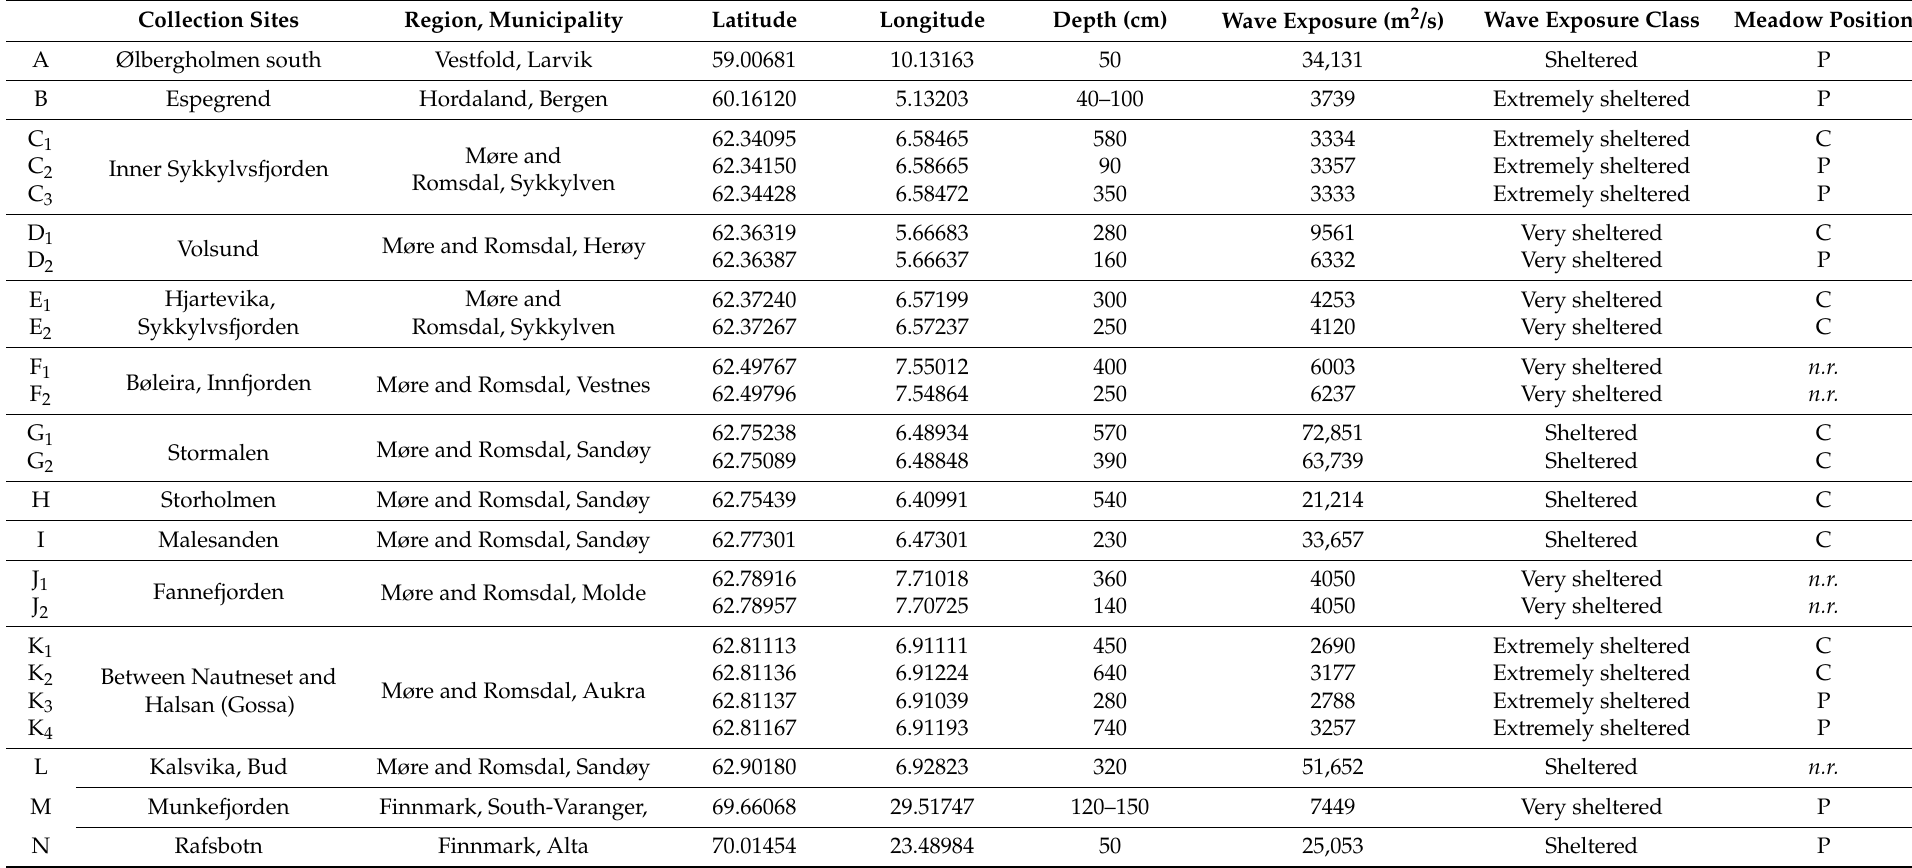
Table 4. Overview of locations, depths and wave exposure (value and classes) for the collected Zostera marina sampling (see Figure